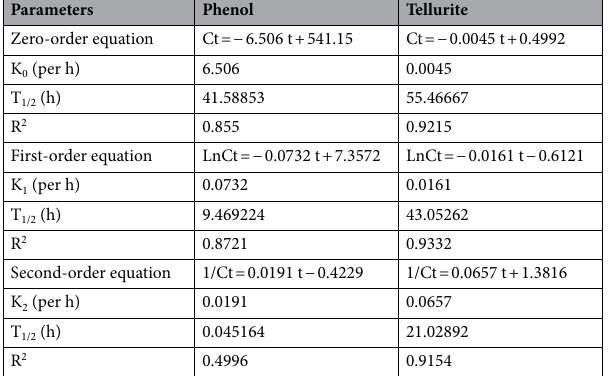
Table 3. Kinetic parameters for 500 mg/L phenol and 0.5 mM tellurite removal in co-contamination cultures.